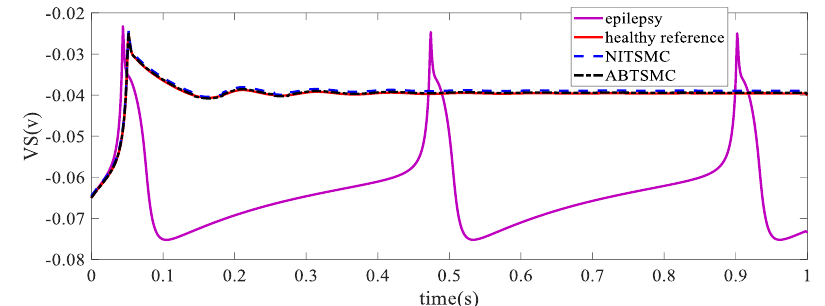
Figure 7. Comparison between ABTSMC and NITSMC control signals.